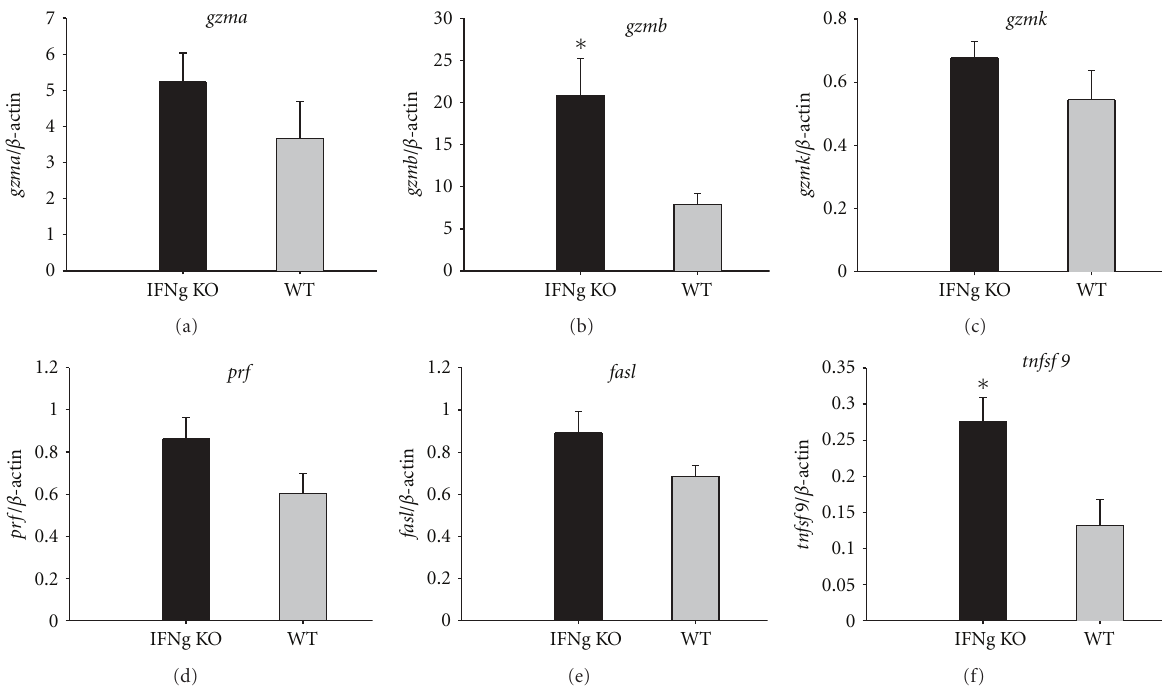
Figure 7: Expression of gzma, gzmb, gzmk, prf1, fasl and tnfsf9 in purified CD8 + cells from SEA-immunized mice, as measured by qRT-PCR (compared with WT mice, ∗ P < 0 . 05, ∗∗ P < 0 . 01).